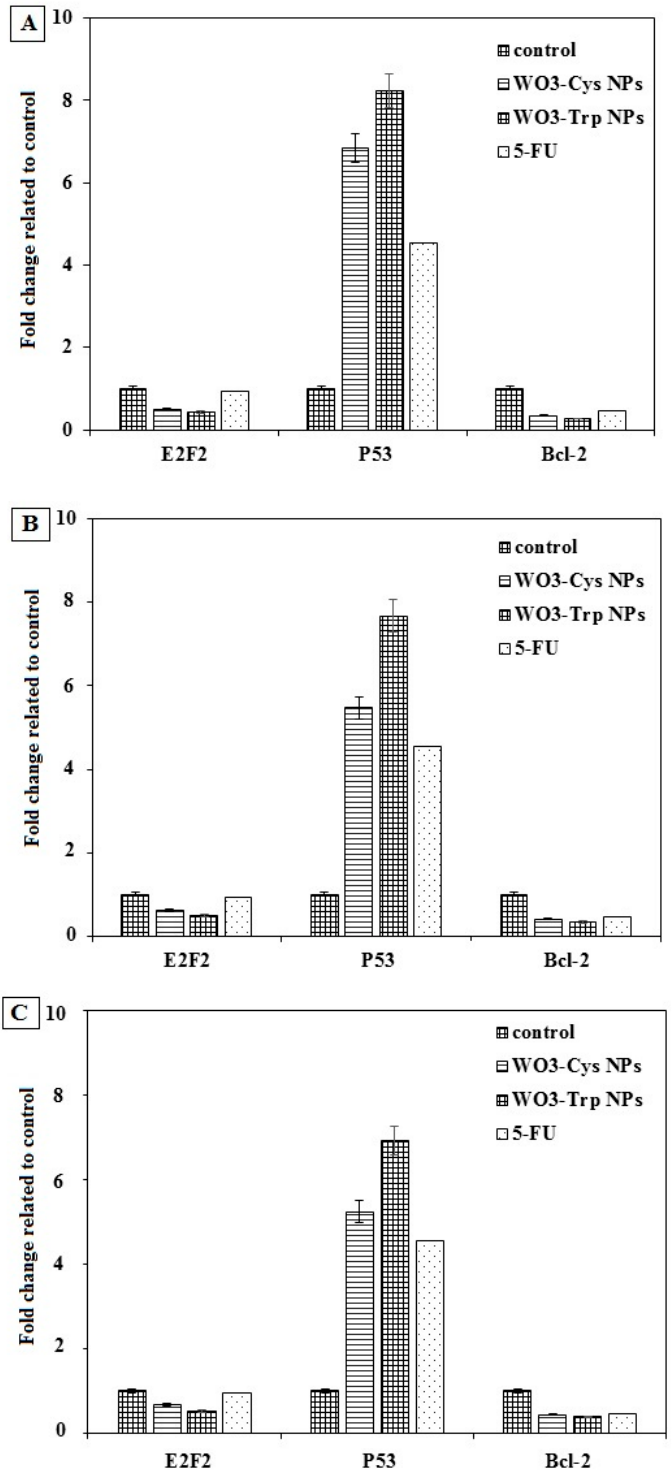
Figure 7. Effects of the modified WO 3 -Cys and WO 3 -Trp NPs on the levels of E2F2, p53, and Bcl- 2 mRNA expression in MCF-7 cells ( A ), Caco-2 cells ( B ), and HepG-2 cells ( C ) treated with IC 50 concentration of each modified NPs and 5-FU for 48 h. The data are presented as mean ± SE and represent the average values from three experiments ( n =